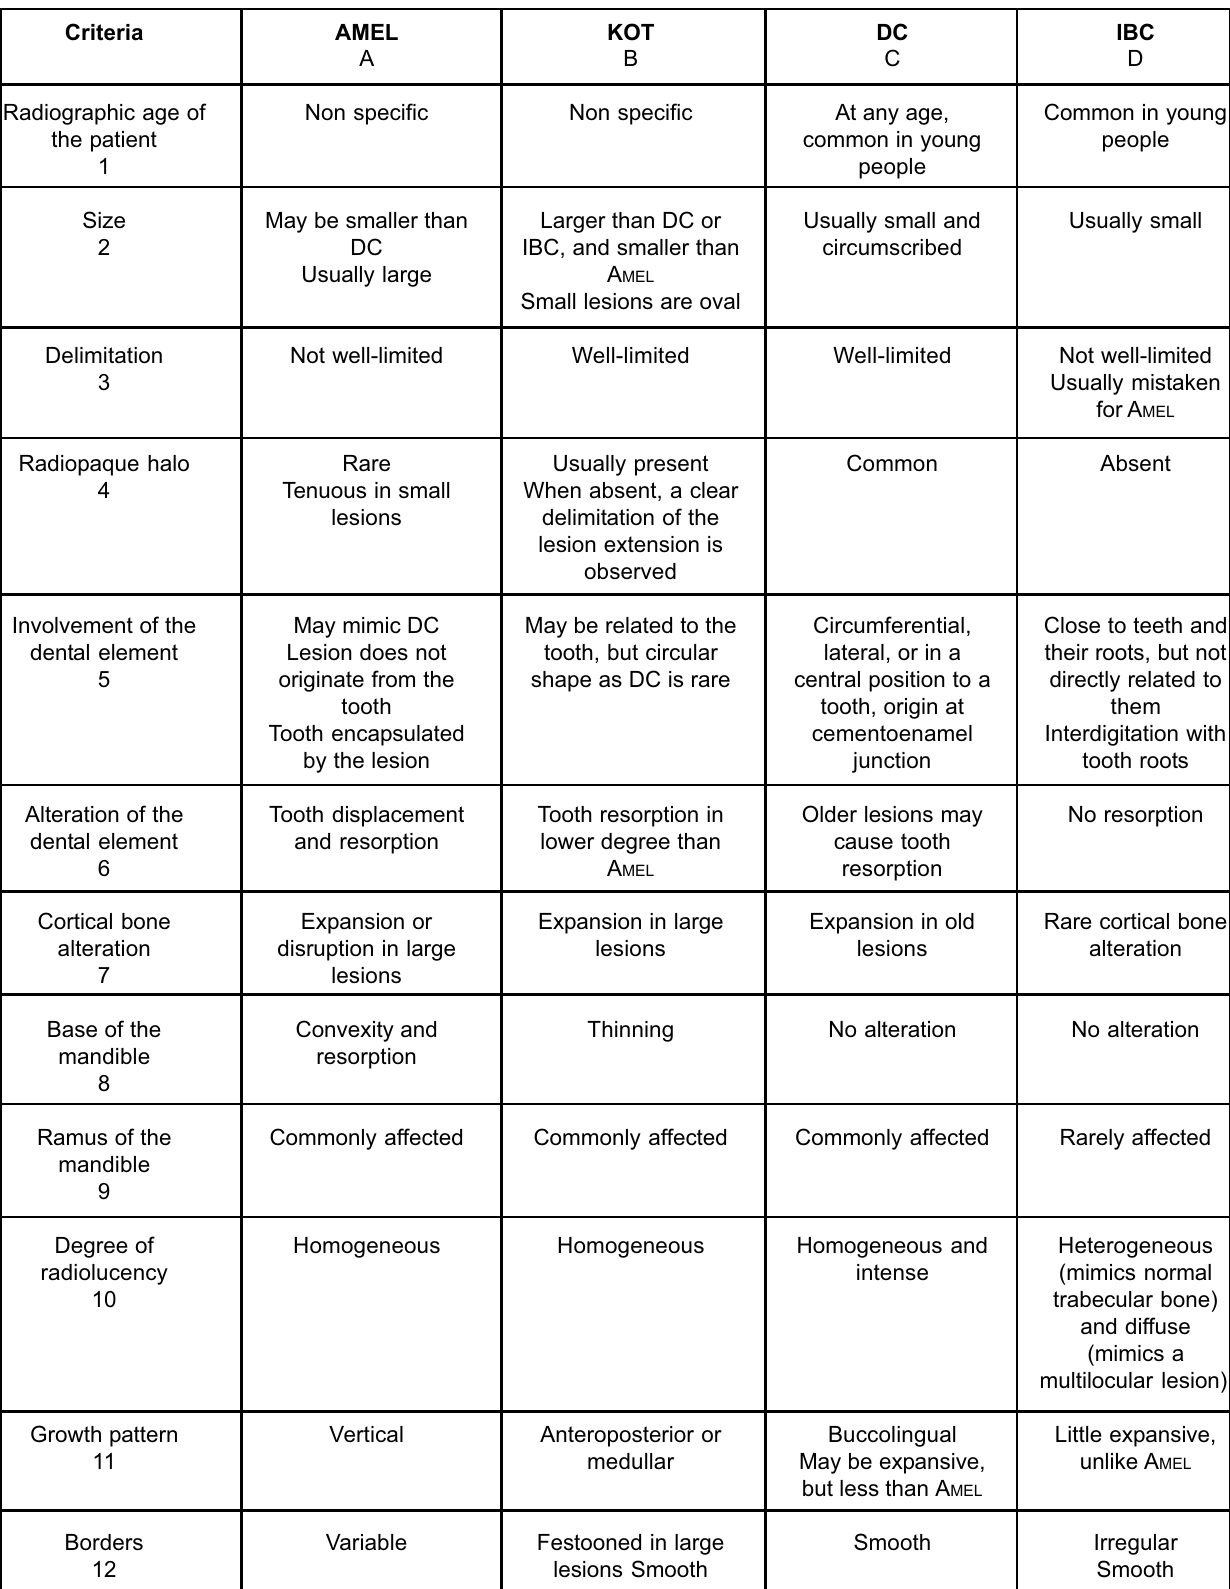
FIGURE 1- Final diagnostic radiographic parameters. AMEL: ameloblastoma; KOT: keratocystic odontogenic tumor; DC: dentigerous cyst; IBC: idiopathic bone